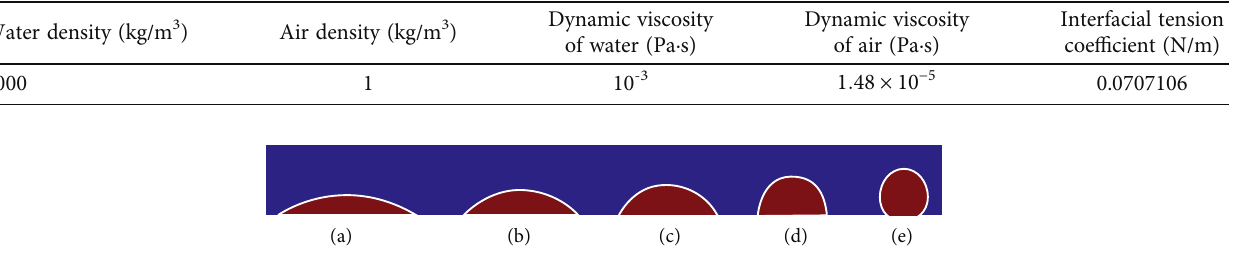
Figure 6: Droplet shape at di ff erent contact angles: (a) θ = 30 o , (b) θ = 45 o , (c) θ = 60 o , (d) θ = 90 o , and (e) θ = 135 o .